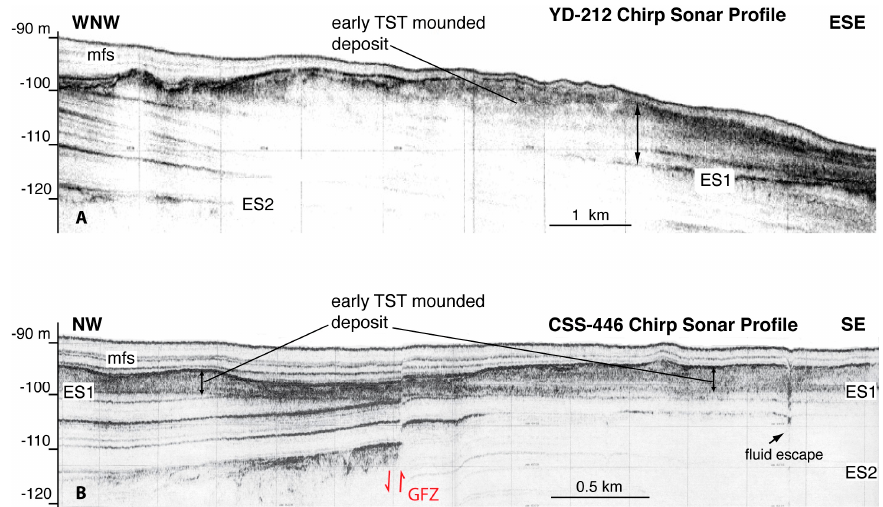
Figure 9. Seismic profiles (location in Figures 1 and 6) showing the opaque seismic units with mounded morphology that represent early TST deposits landward of the E-Gargano shelf edge TSR. From NE ( A ) to SW (( B ) modified from [51]), the mounded morphology and relief attenuate below a progressively thicker cover of late TST and HST deposits. Further landward, the early TST deposits pass laterally and vertically to the middle TST (area not mapped in Figure 6). Profile CSS-446 ( A ) shows displacement along the GFZ, also responsible for differential uplift/lowering of shelf sectors.